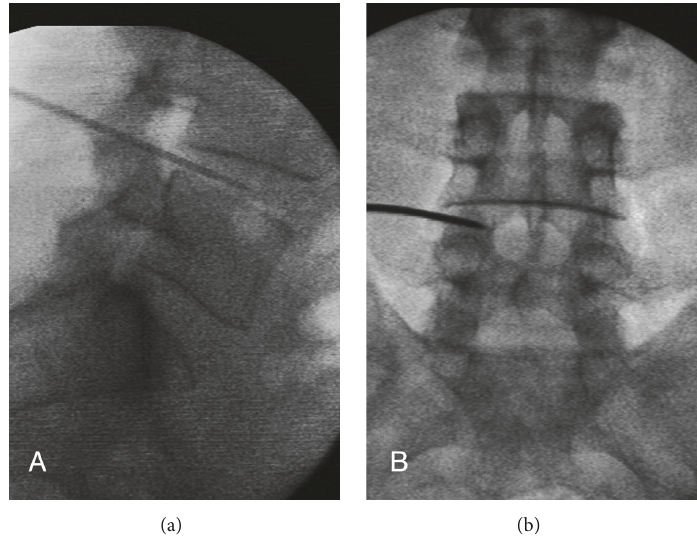
Figure 1: AP and lateral fluoroscopy image of the position of the PLDD wand at